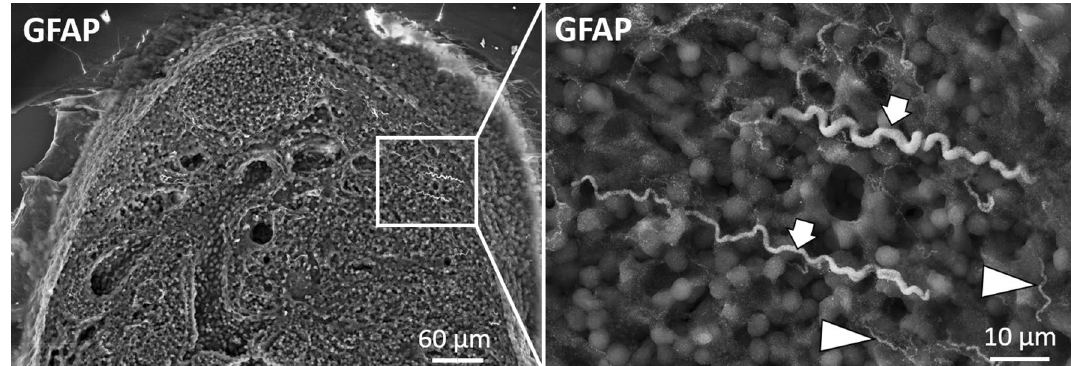
Figure 10. Mandibular lymph node stained with polyclonal anti-GFAP antibody (DAKO) and secondary FluoroNanogold. Two major nerves in the middle of the medullary area (see arrows in enlargement) proceeding towards the capsule and many small thin structures (arrowheads) are marked with gold.